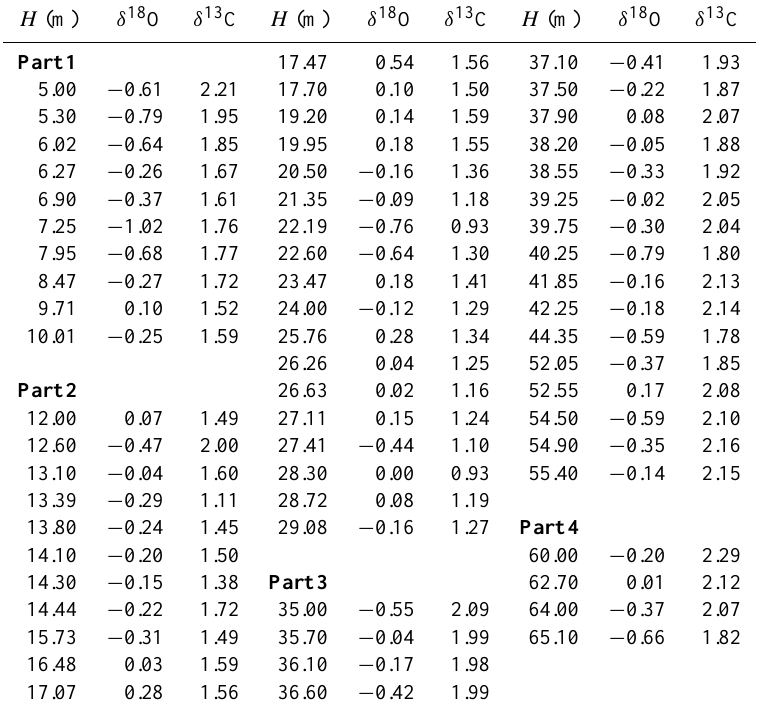
Table 3. Stable isotope composition of oxygen and carbon in limestones of the Pizzo Mondello section. Stratigraphic heights ( H ) as in Fig. 2.